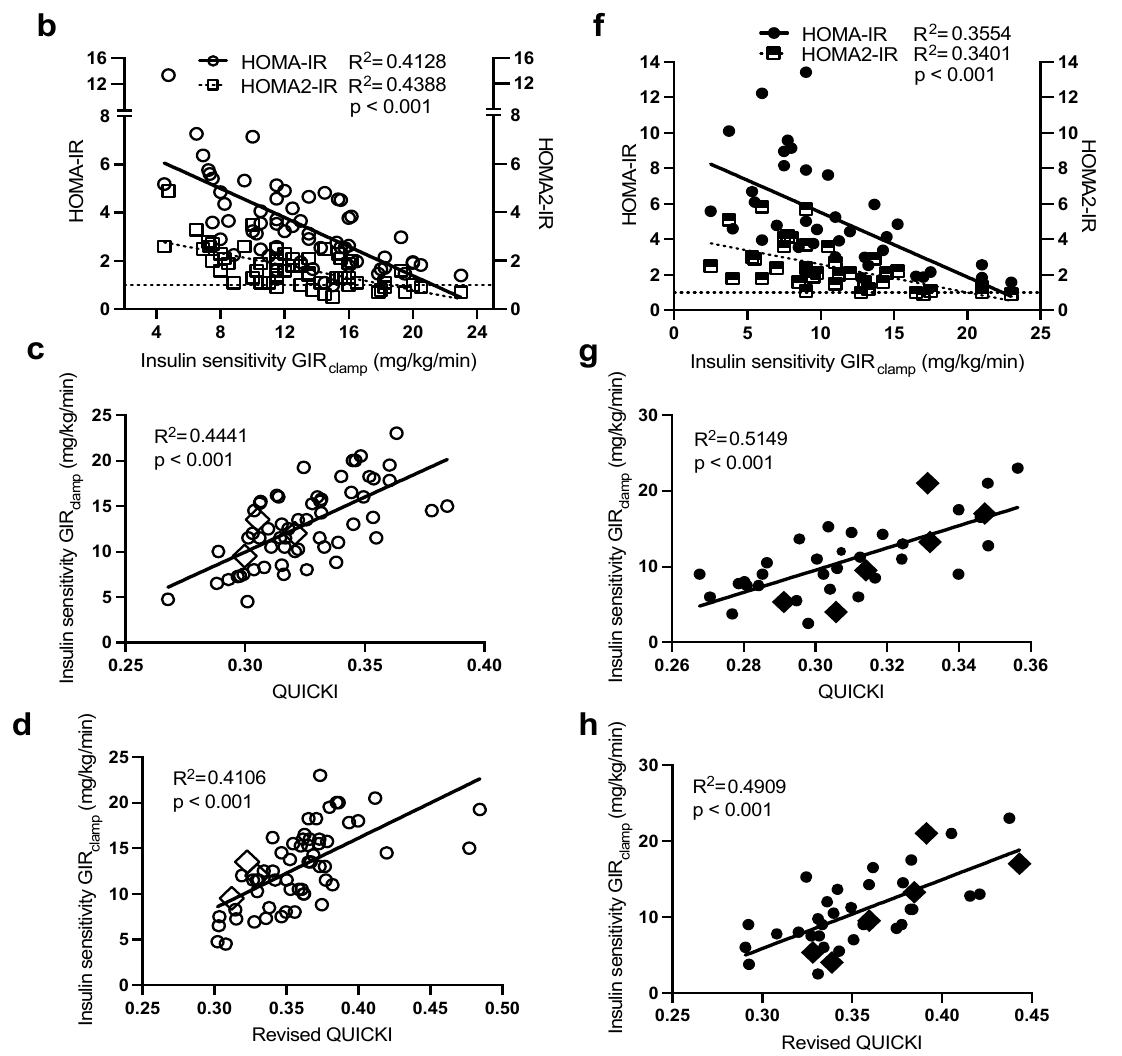
Figure 3. Pearson correlations between HIEG clamp measures of IS (GIR clamp ), with the sex-specific models for IS in women ( a ) and men ( e ), HOMA-IR and HOMA2-IR in women ( b ) and men ( f ), QUICKI in women ( c ) and men ( g ), and QUICKI-FFA in women ( d ) and men ( h ). Women are in open circles (N = 61, those with BMI > 40 kg/m 2 are in open diamonds) and men are in closed circles (N = 37, those with BMI > 40 kg/m 2 are in closed diamonds).